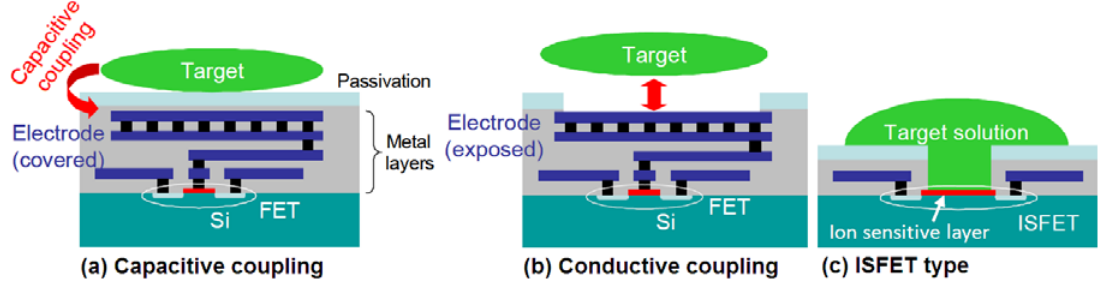
Figure 6. Illustration of the range of concepts and configurations of on-chip “passive” electric sensing that are using the gate of a MOS transistor as the sensing input, namely the capacitive coupling ( a ), conductive coupling ( b ), and ISFET type ( c ) [79]. Reproduced from the Open Access publication